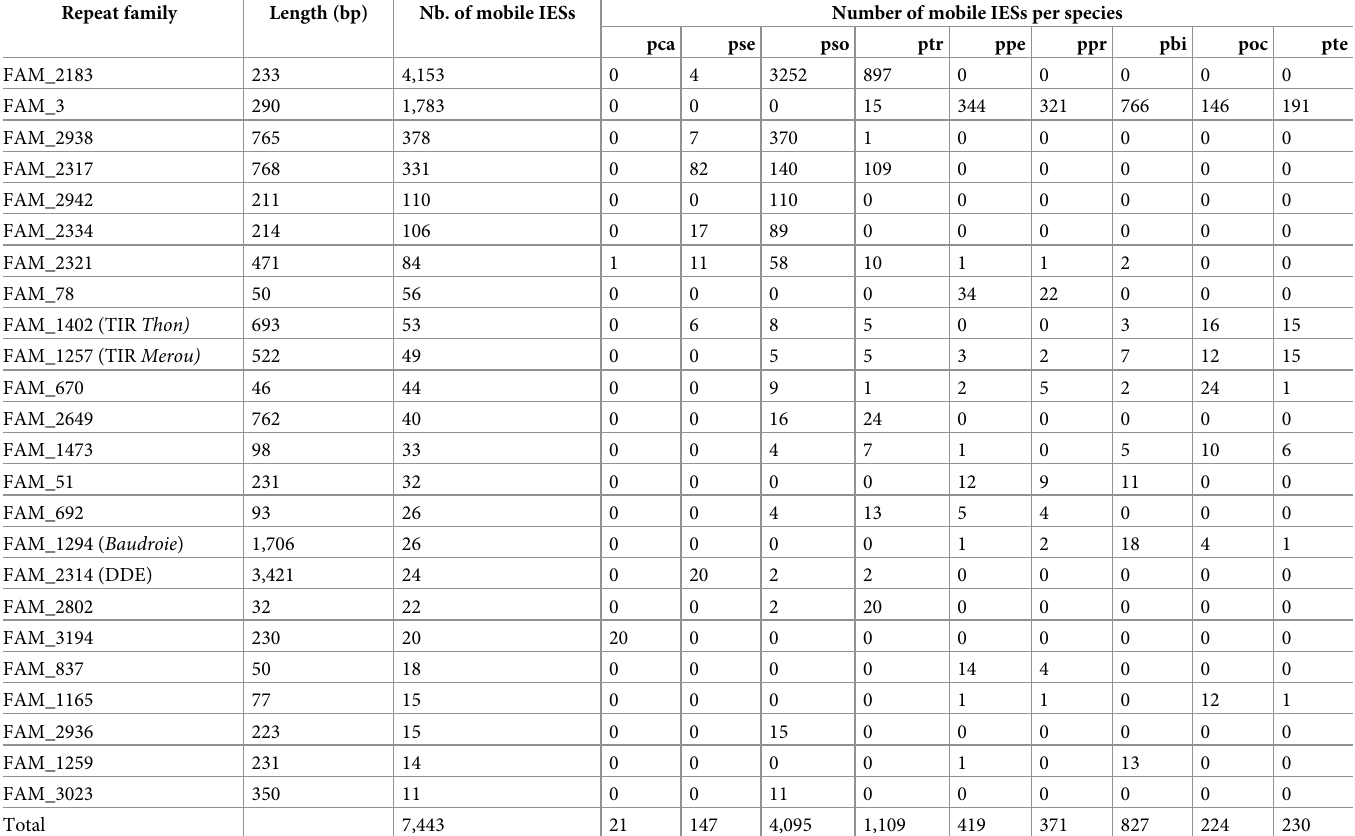
Table 2. Taxonomic distribution of mobile IESs. Copies of mobile IESs were searched among IES sequences (see Materials and methods). Detected copies were divided in 2 categories: nested copies (i.e., copies inserted within an IES, but not including the extremities of the IES) and bona fide mobile IESs (i.e., copies whose extremities cor- respond to the extremities of the IES). This table lists all families for which at least 1 species contains � 10 copies of bona fide mobile IESs in its genome (see S4 Table for information on nested copies). Species codes: pbi, P . biaurelia ; pca, P . caudatum ; poc, P . octaurelia ; ppe, P . pentaurelia ; ppr, P . primaurelia ; pso, P . sonneborni ; pse, P . sex- aurelia ; pte, P . tetraurelia ; ptr, P . tredecaurelia